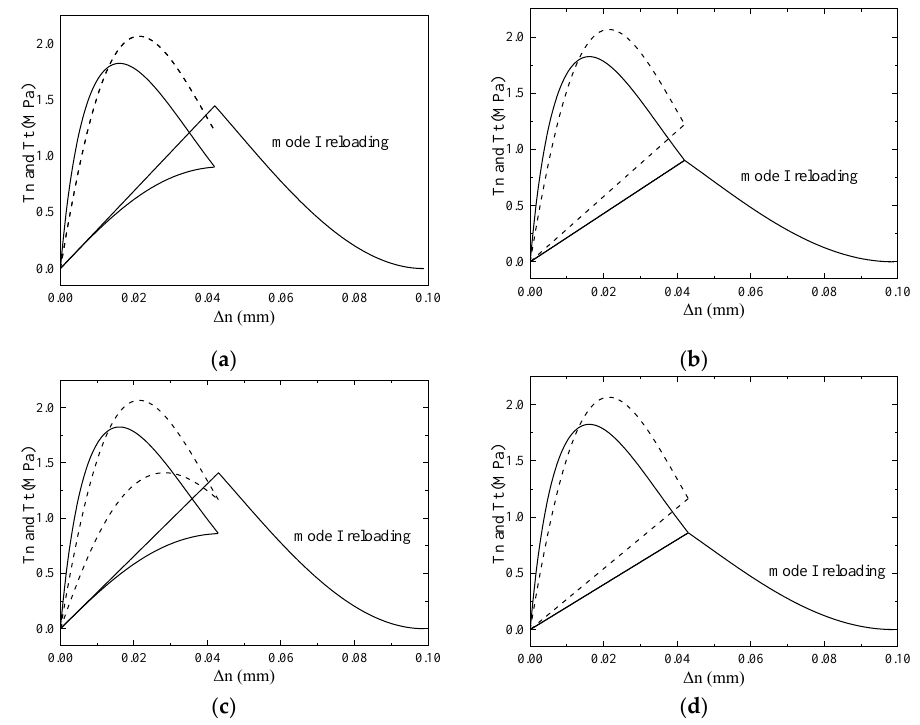
Figure 17. Variations of the traction components 𝑇 𝑛 (solid lines) and 𝑇 𝑡 (dashed lines) during the process of proportional loading/unloading and mode I reloading, for a proportional loading amplitude of ∆ = 0.042 mm ( a , b ); or ∆ = 0.043 mm ( c , d ). Model (i) ( a,c ); and model (ii) and model (iii) ( b,d ).